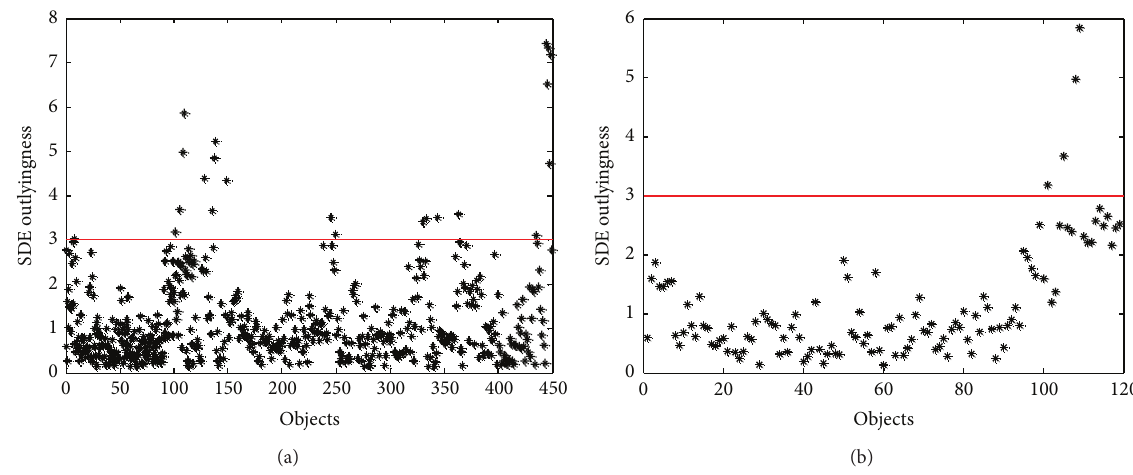
Figure 2: The Stahel-Donoho estimates (SDE) of outlyingness values for ATT (a) and NATT